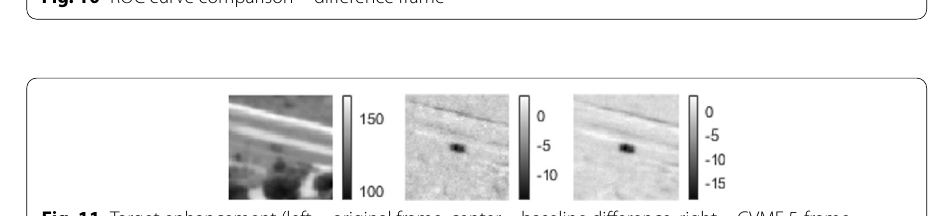
Fig. 10 ROC curve comparison—difference frame